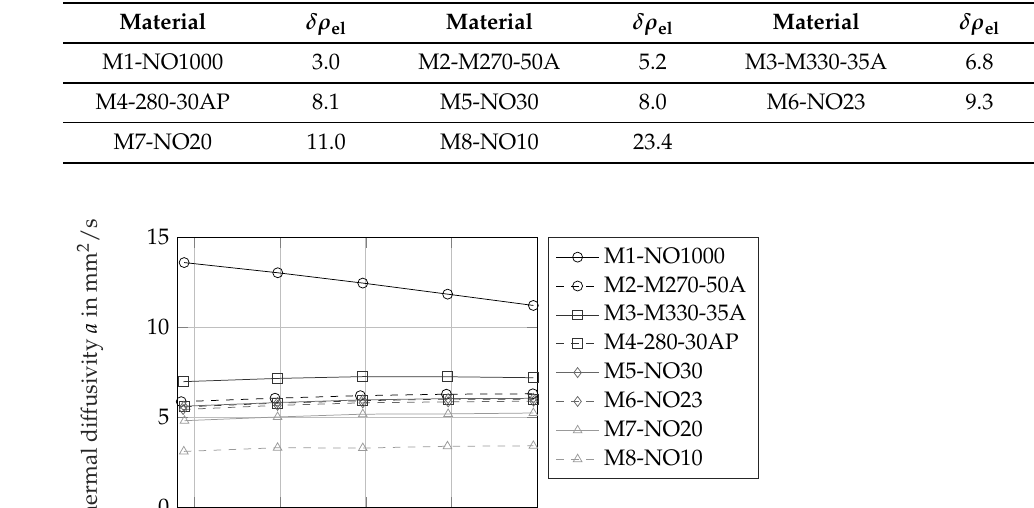
Table 5. Estimated measurement error of the thermal diffusivity measurement x = a in %.